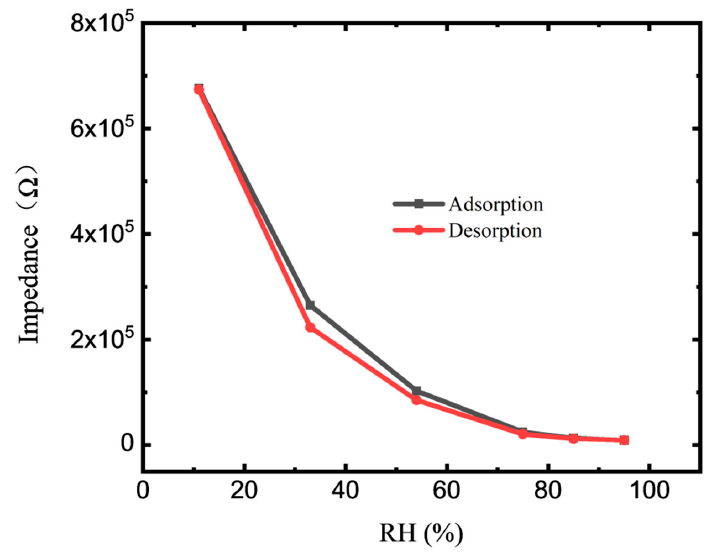
Figure 4. Hysteresis characteristic of the GO-based sensor at 100 Hz.